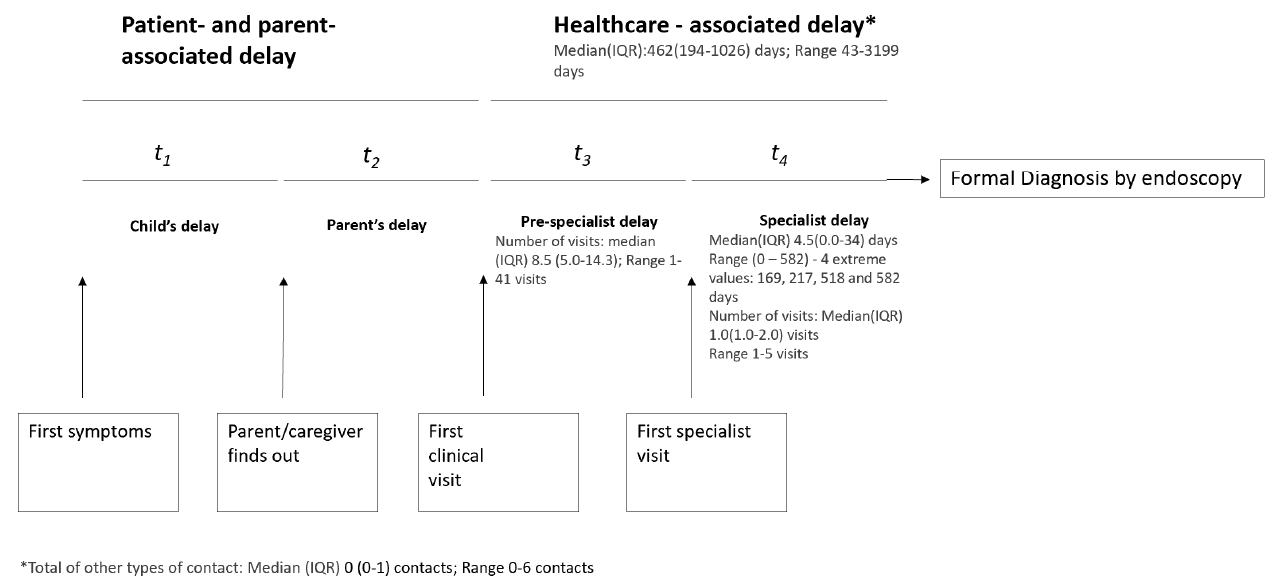
Figure 2. Diagnostic delay timeline and the variables of interest